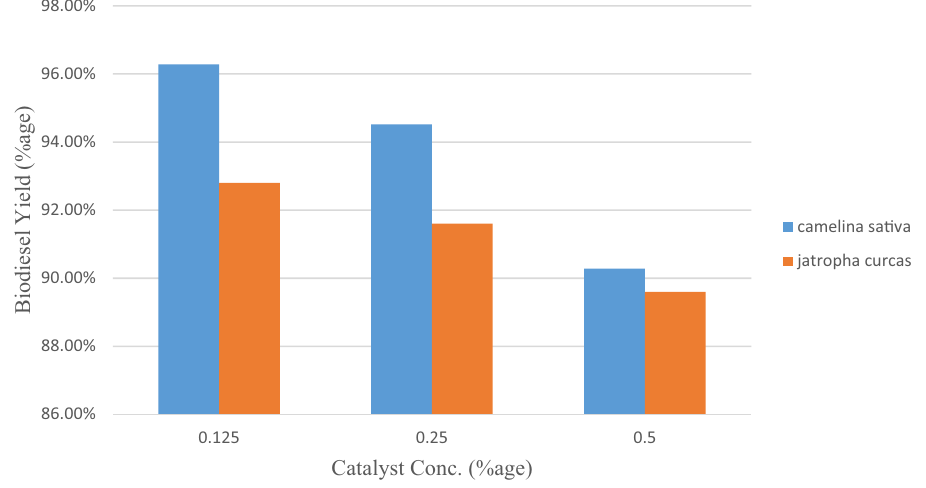
Figure 2. Effect of KOH concentration on biodiesel yield (%) from Camelina and Jatropha seed oil.